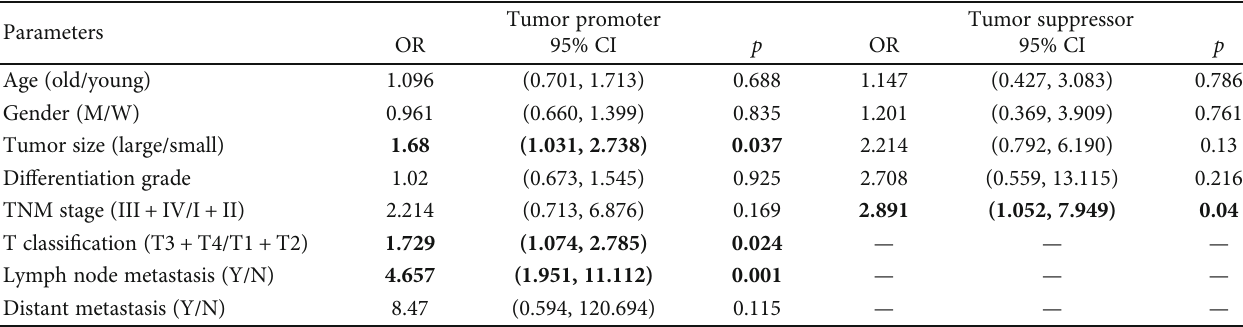
Figure 5: Forest plots of pooled PLR and NLP of circRNAs for EC. PLR, positive likelihood ratio; NLR, negative likelihood ratio; circRNAs, circular RNAs; EC, esophageal cancer. Table 4: Clinical parameters of circRNAs in esophageal